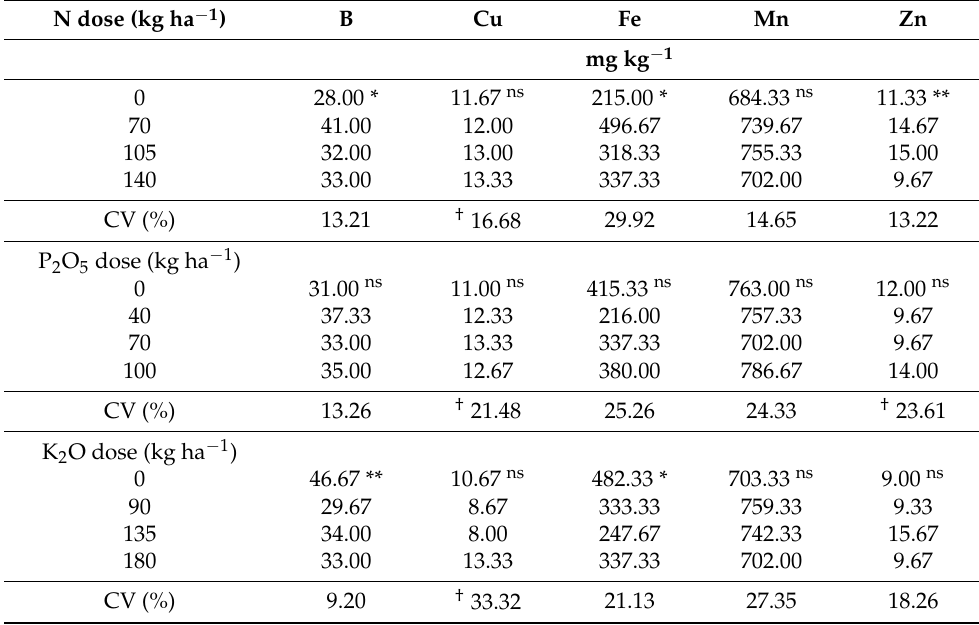
Table 4. Micronutrient contents in eucalyptus leaf litter as a function of residual dose of N, P 2 O 5 and K 2 O. N dose (kg ha − 1 ) * and ** = significant at 5 and 1% level by F test, respectively; ns = not significant at 5% level by F test. † Data corrected by the equation (x + 0.5) 0.5